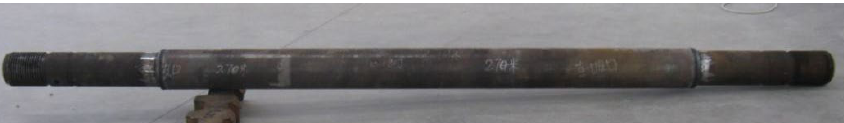
Figure 5. The specimens before collapse.